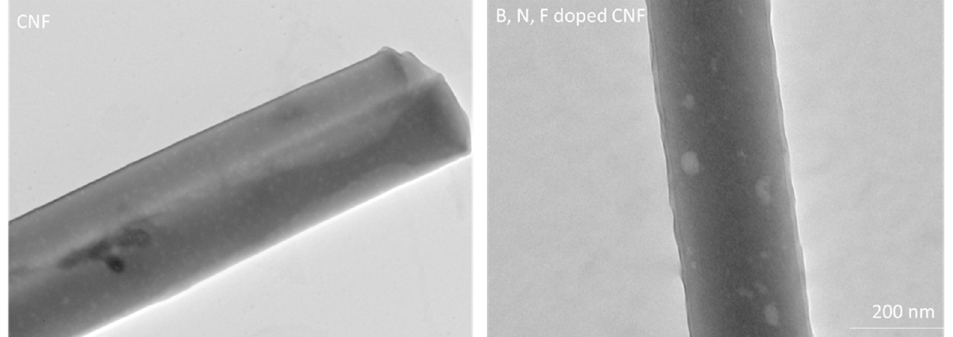
Figure 7. TEM images of centrifugally spun CNFs and B, N, F-doped